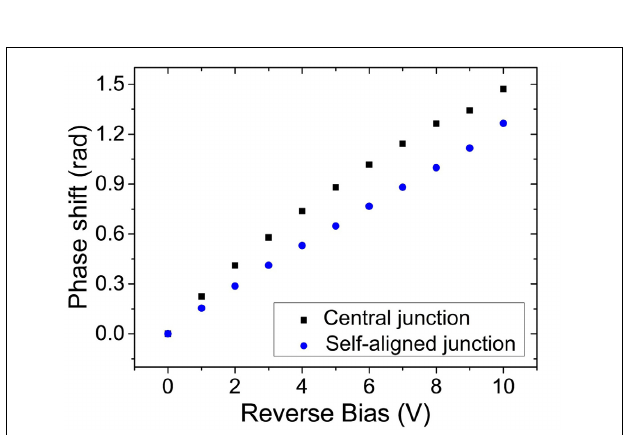
FIGURE 5 | Optical eye diagram obtained from a device with 1mm phase modulators at